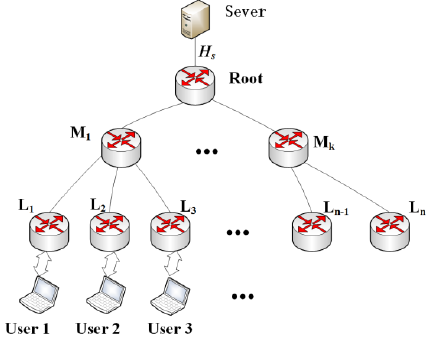
Figure 1. A three-level Cache Network System Model.